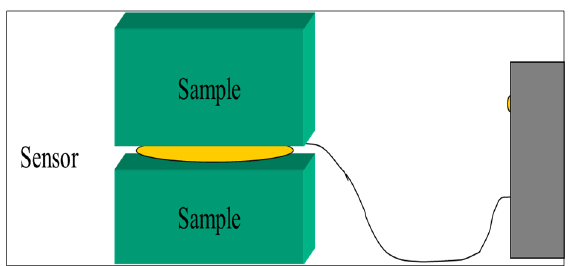
Fig.11.hot disk